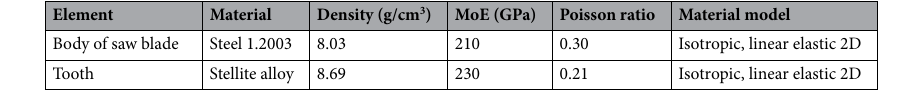
Table 5. Basic material properties of the analysed saw blades.